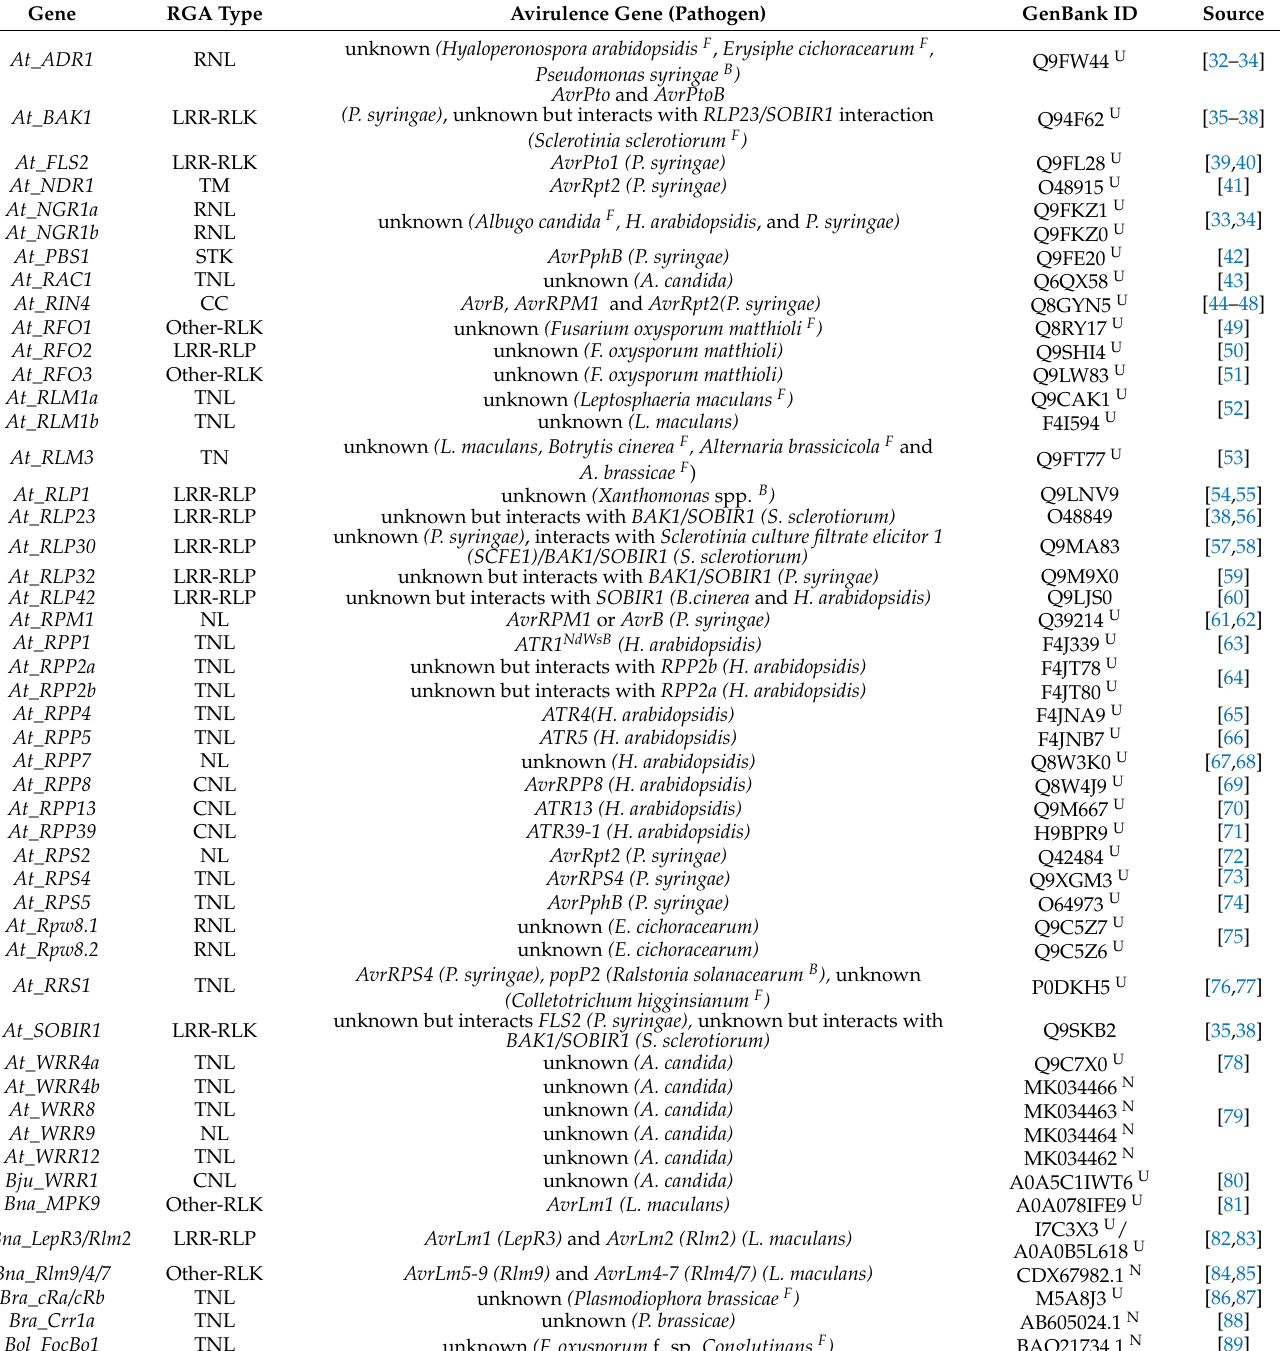
Table 1. The 49 cloned R genes from Arabidopsis thaliana (At) , Brassica juncea (Bju) , Brassica napus (Bna) and Brassica rapa (Bra) used for homology